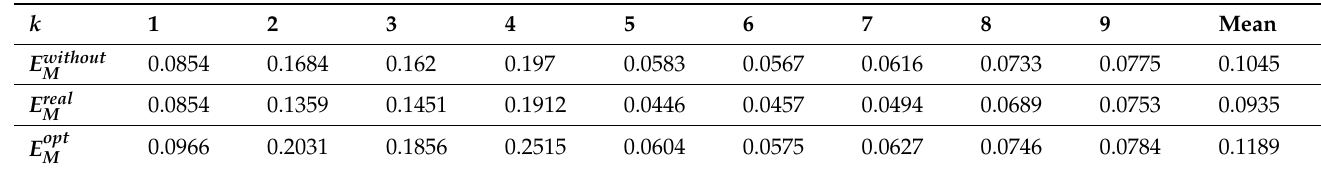
Table 7. Comparisons between the income’s values with and without the application of active business management.